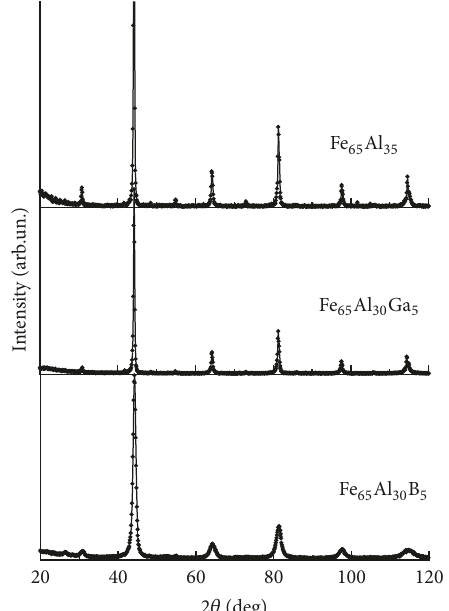
Figure 1: X-ray-diffraction patterns of the quasi-ordered Fe 65 Al 35 and Fe 65 Al 35−𝑥 M 𝑥 (M 𝑥 = Ga, B; 𝑥 = 5 at.%) alloys. Cu K 𝛼 -radiation, 𝑇 = 300